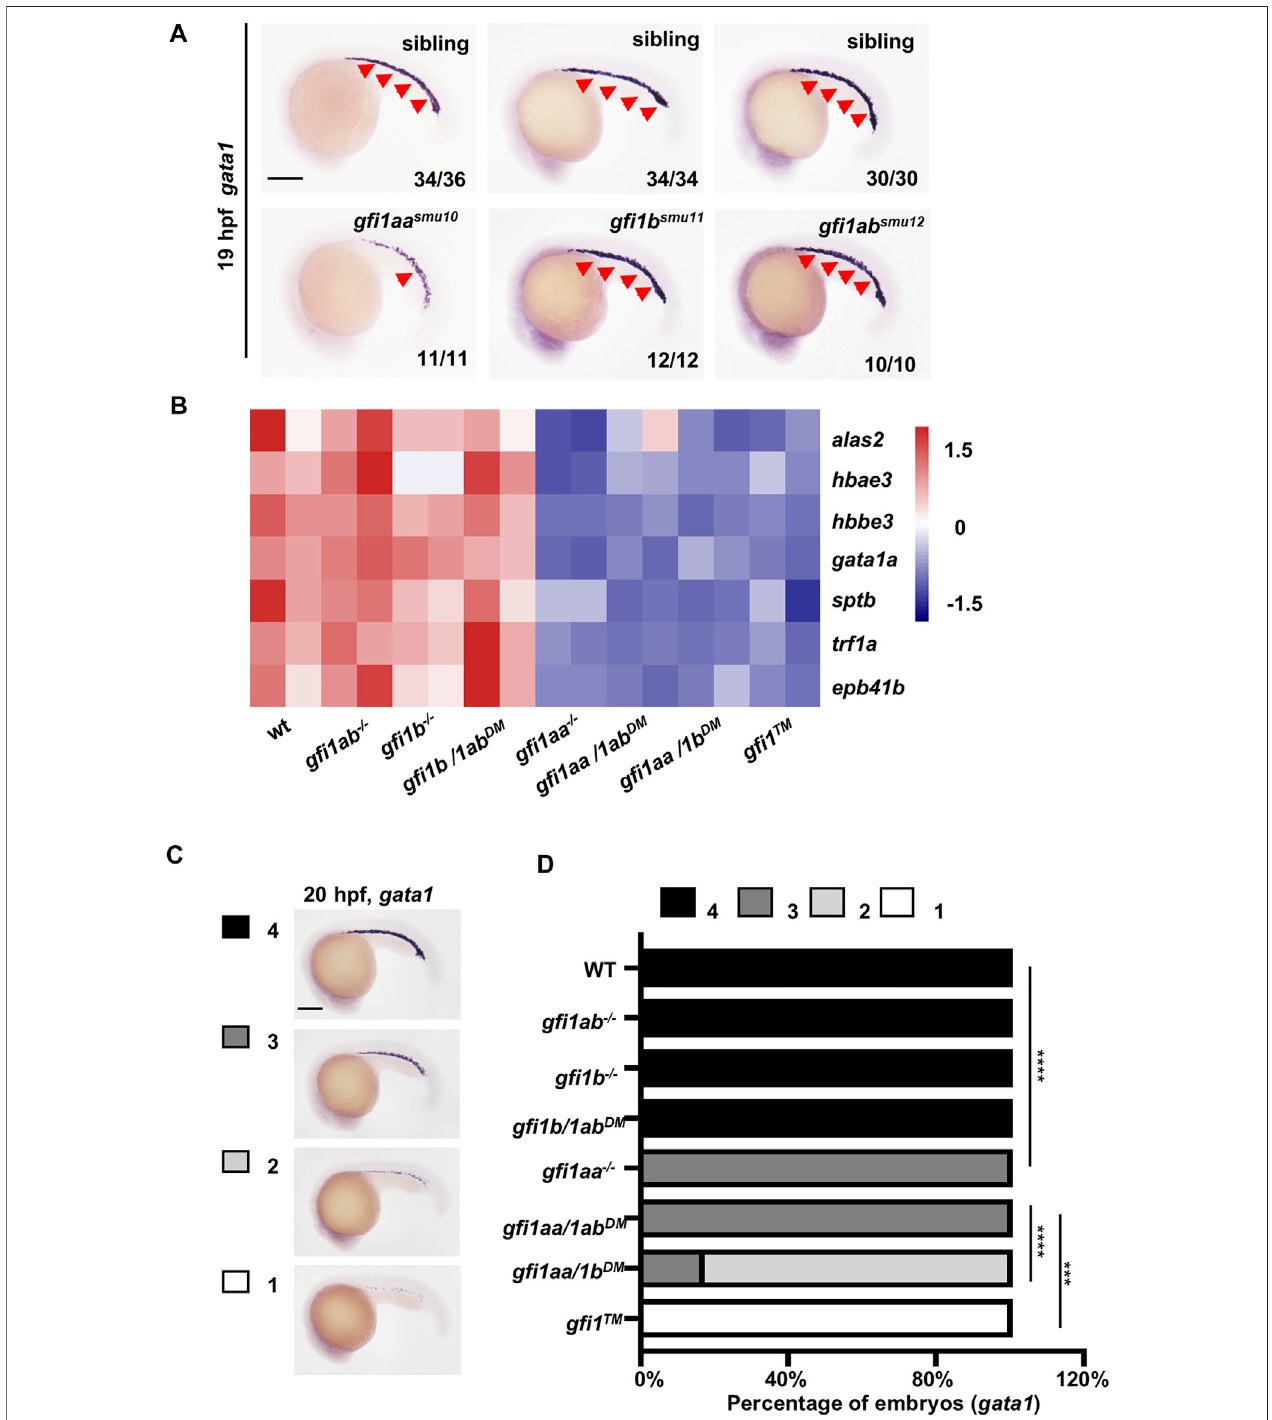
FIGURE 1 | g fi 1aa plays the key role in primitive erythropoiesis (A) Expression of gata1 was increased in g fi 1aa smu10 mutants compared to siblings, whereas g fi 1b smu11 and g fi 1ab smu12 mutants shownormal gata1 expression at 19hpf byWISH. Thenumbers inthelowerright corner indicate representative expression embryo numbers of the indicated marker. Scale bar: 200 μ m (B) Heatmap of WT, g fi 1aa − / − , g fi 1b − / − , g fi 1ab − / − signal mutant, g fi 1aa/1b DM , g fi 1aa/1ab DM , g fi 1b/1ab DM double mutant and g fi 1 TM triple mutant shows the gene expression levels of erythroid genes ( alas2 , hbae3 , hbbe3 , gata1a , sptb , trf1a, and epb41b ). The color scale indicatedtheexpressionlevel (C,D) Expressionof gata1 wasdecreasedin g fi 1aa relatedmutant( g fi 1aa − / − , g fi 1aa/1ab DM , g fi 1aa/1b DM ,and g fi 1 TM )comparedtoWTand other mutants at 20 hpf by WISH (C) The g fi 1aa +/- ; g fi 1b +/- ; g fi 1ab +/- intercross embryos were divided into four categories according to gata1 expression (D) The percentage of WT, g fi 1aa − / − , g fi 1b − / − , g fi 1ab − / − signal mutant, g fi 1aa/1b DM , g fi 1aa/1ab DM , g fi 1b/1ab DM double mutant and g fi 1 TM triple mutant according to the categories (**** p < 0.0001, *** p < 0.001, Fisher exact tests, n ≥ 10 for each group).